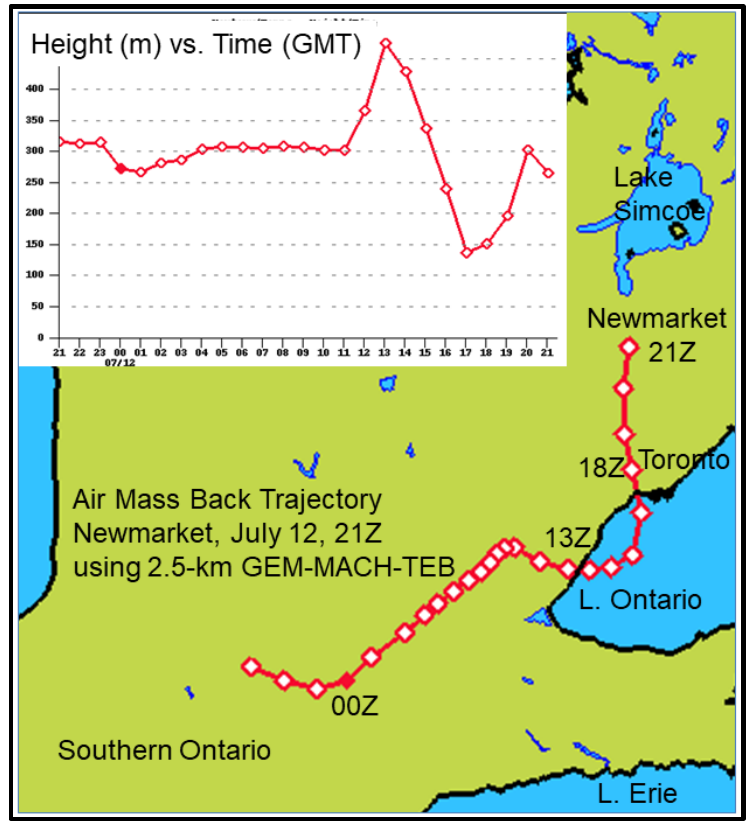
Figure 20. A 24-h air-mass back trajectory for Newmarket starting at 21:00 UTC 12 July 2015, using the 2.5-km GEM-MACH-TEB wind output. 2.5-km GEM-MACH-TEB wind output. Table 5. Modelled and measured temperatures over Lake Ontario on 12 July